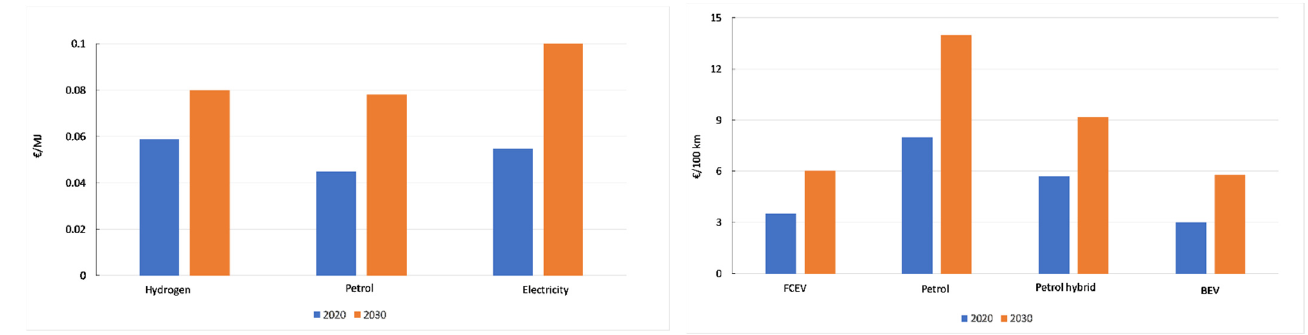
Figure 6. Fuel cost per 100 km for petrol vehicles, hybrid vehicles, EV, and FCEV in 2020–2030 [26].